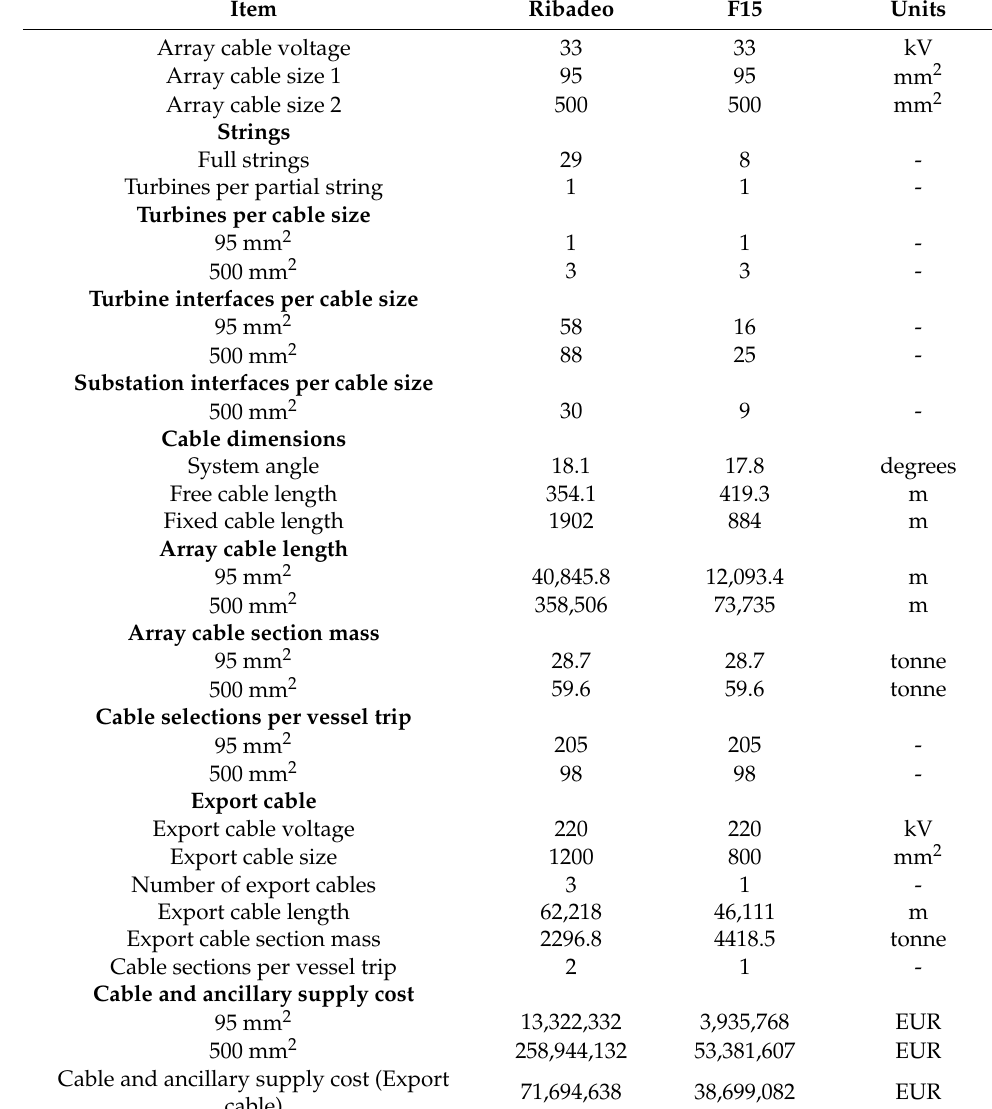
Table 4. Electrical system